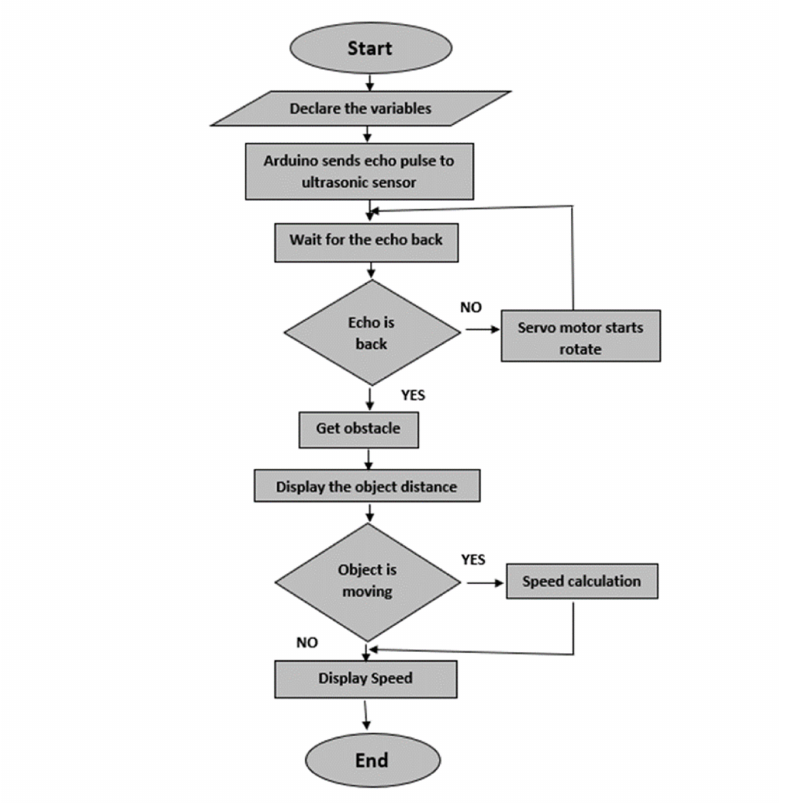
Fig. 4 Representing the work in a flowchart